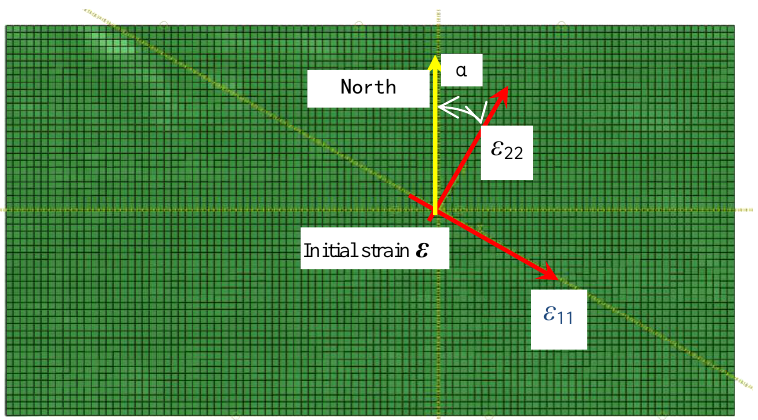
Figure 6. Illustration of initial strain and its principal directions.